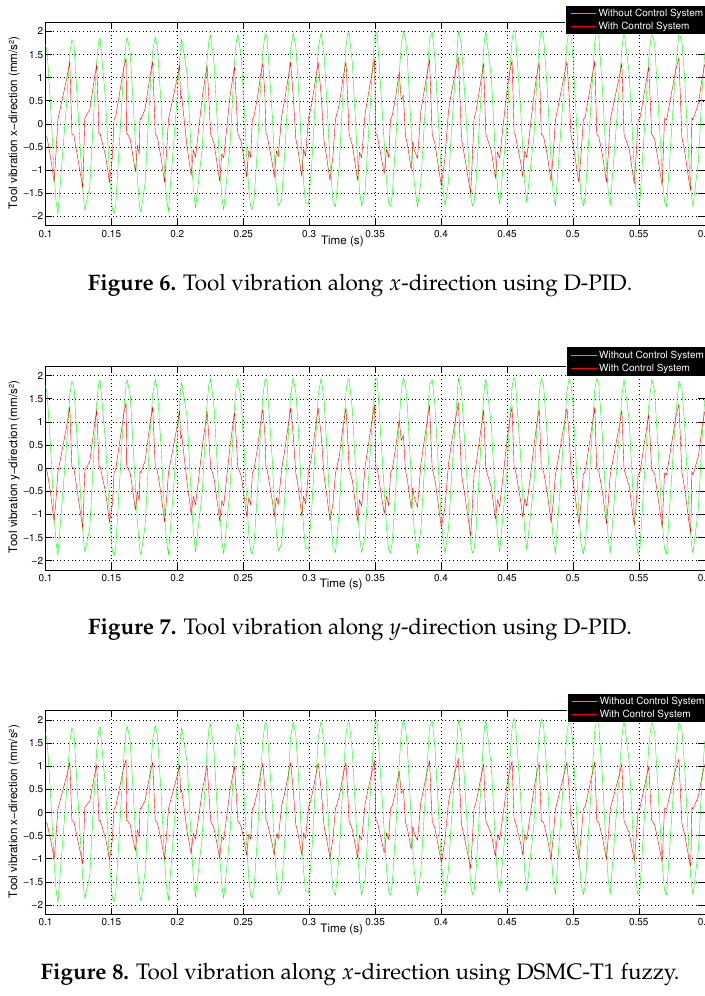
Figure 8. Tool vibration along x -direction using DSMC-T1